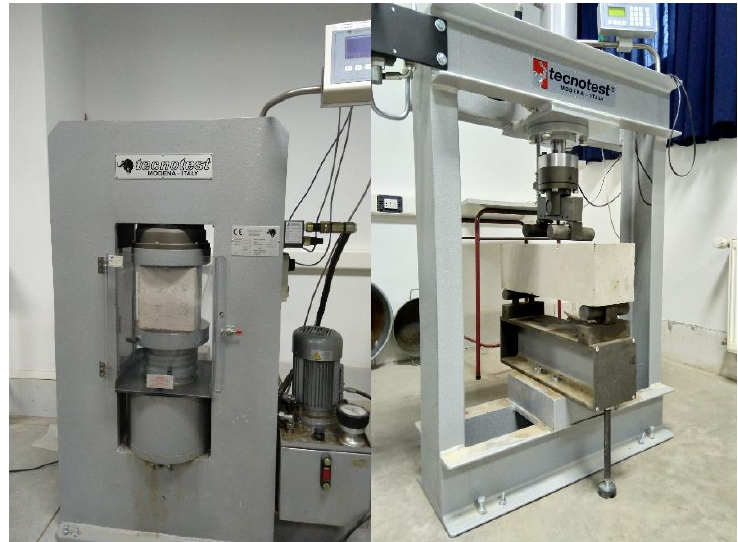
Figure 3. Blocks compression and flexural tests.